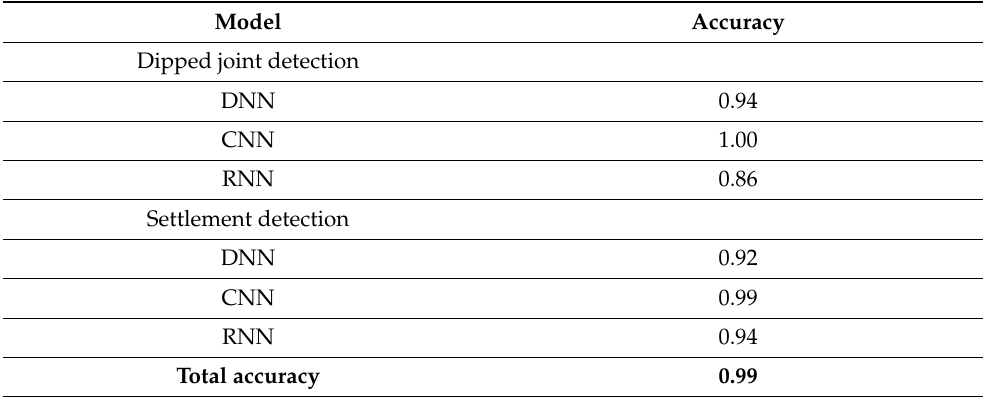
Table 7. Performance of each model for detecting dipped joint and